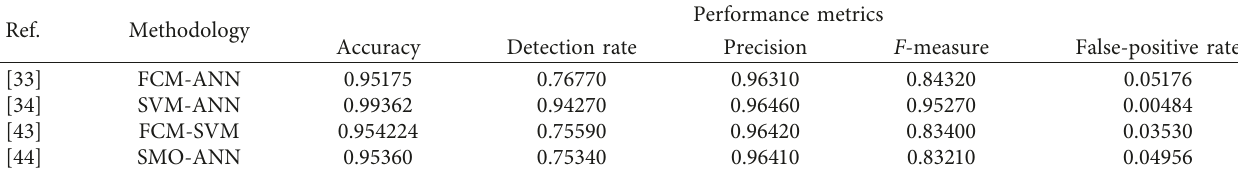
Table 18: Comparison of various methodologies based on different performance metrics for the NSL-KDD dataset.